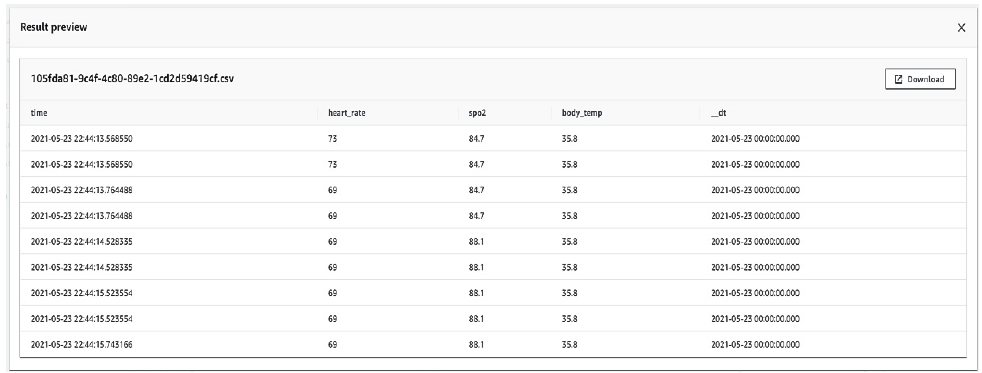
Figure 12. Preview of sensed parameters on AWS